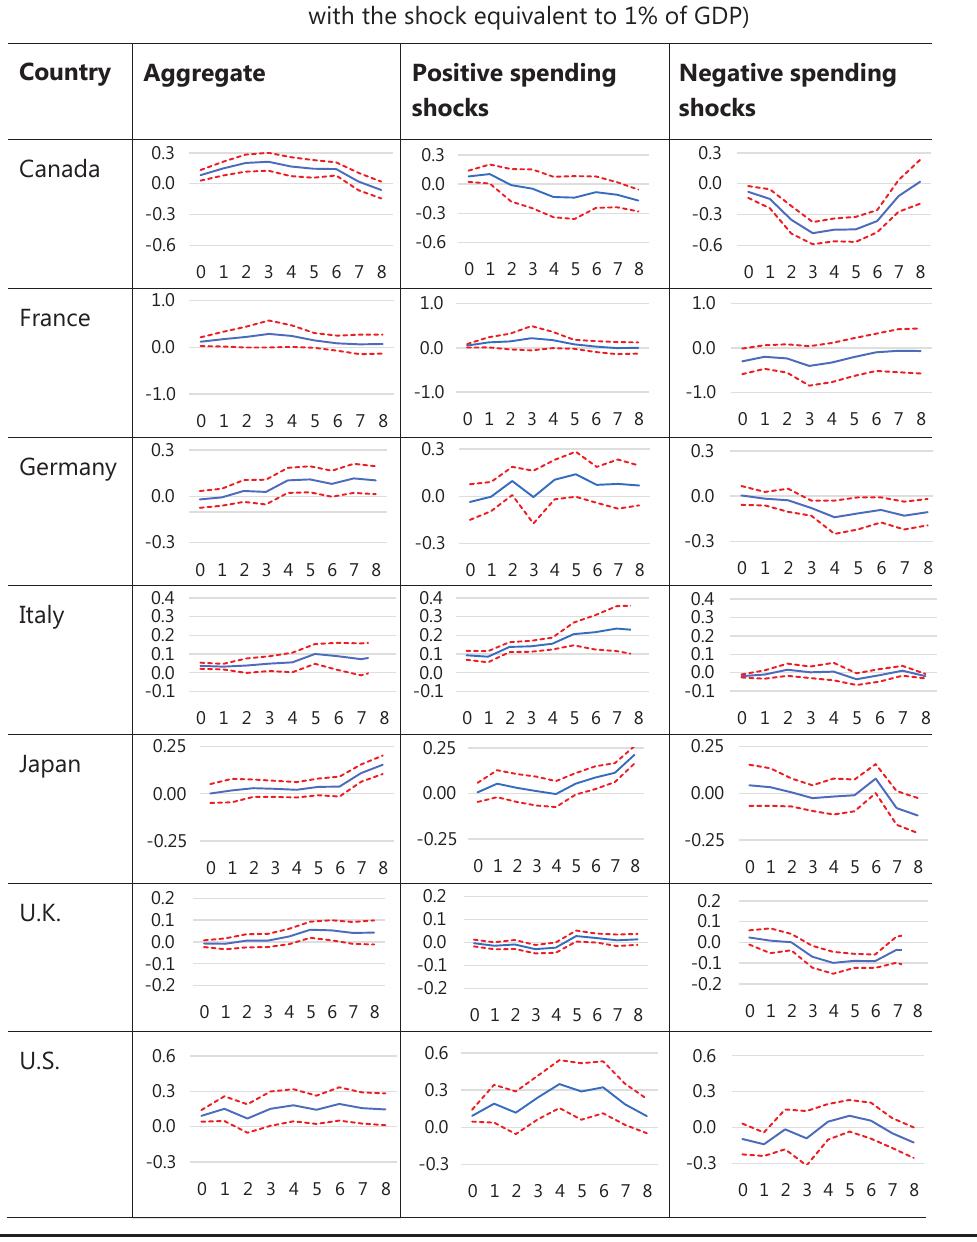
Figure 6 Effects of government spending shocks on gender equality. (Changes in the female share of employment in percent, with the shock equivalent to 1% of GDP) Aggregate Positive spending Negative spending shocks shocks